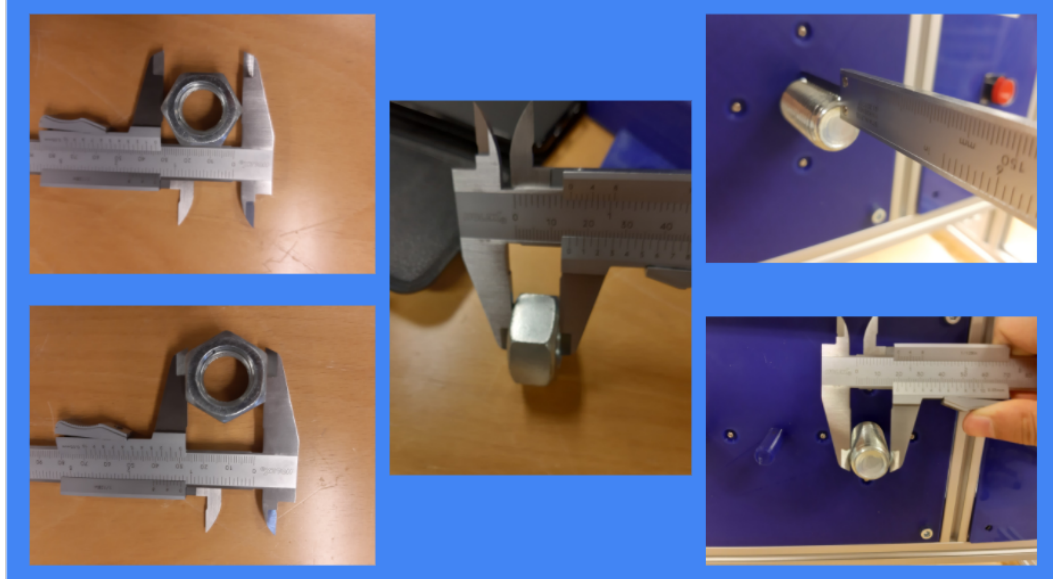
Figure 8. Students measuring the panel in order to design the tool to accomplish the Unscrew Mission.